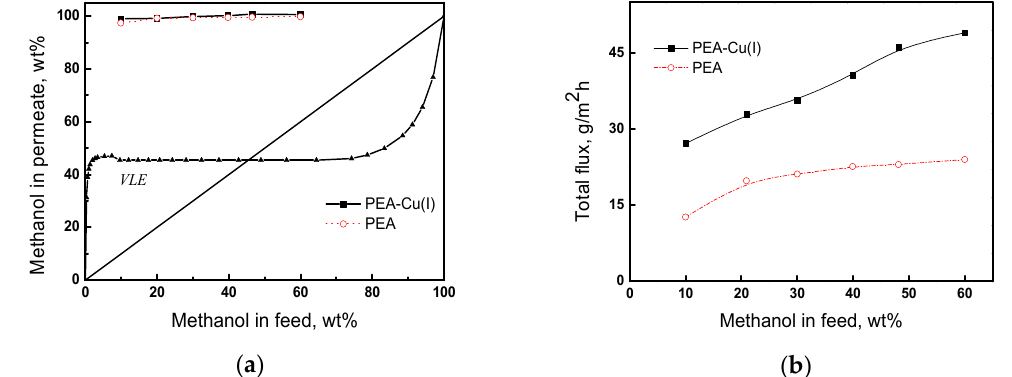
Figure 9. ( a ) Dependence of methanol concentration in the permeate on methanol concentration in the feed for the pervaporation and vapor–liquid equilibrium curve (VLE) of methanol and n -heptane mixture; ( b ) dependence of total flux on the methanol concentration in feed, 20 ° С .